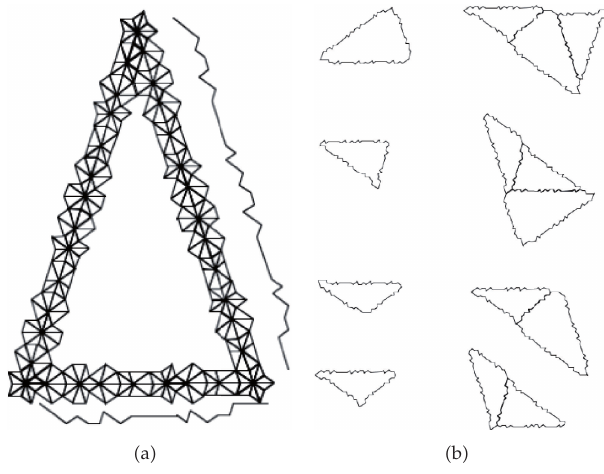
Figure 5: Pentagonal tiling with irregular shapes: (cid:6) a (cid:7) construction of the boundaries, (cid:6) b (cid:7) inflation